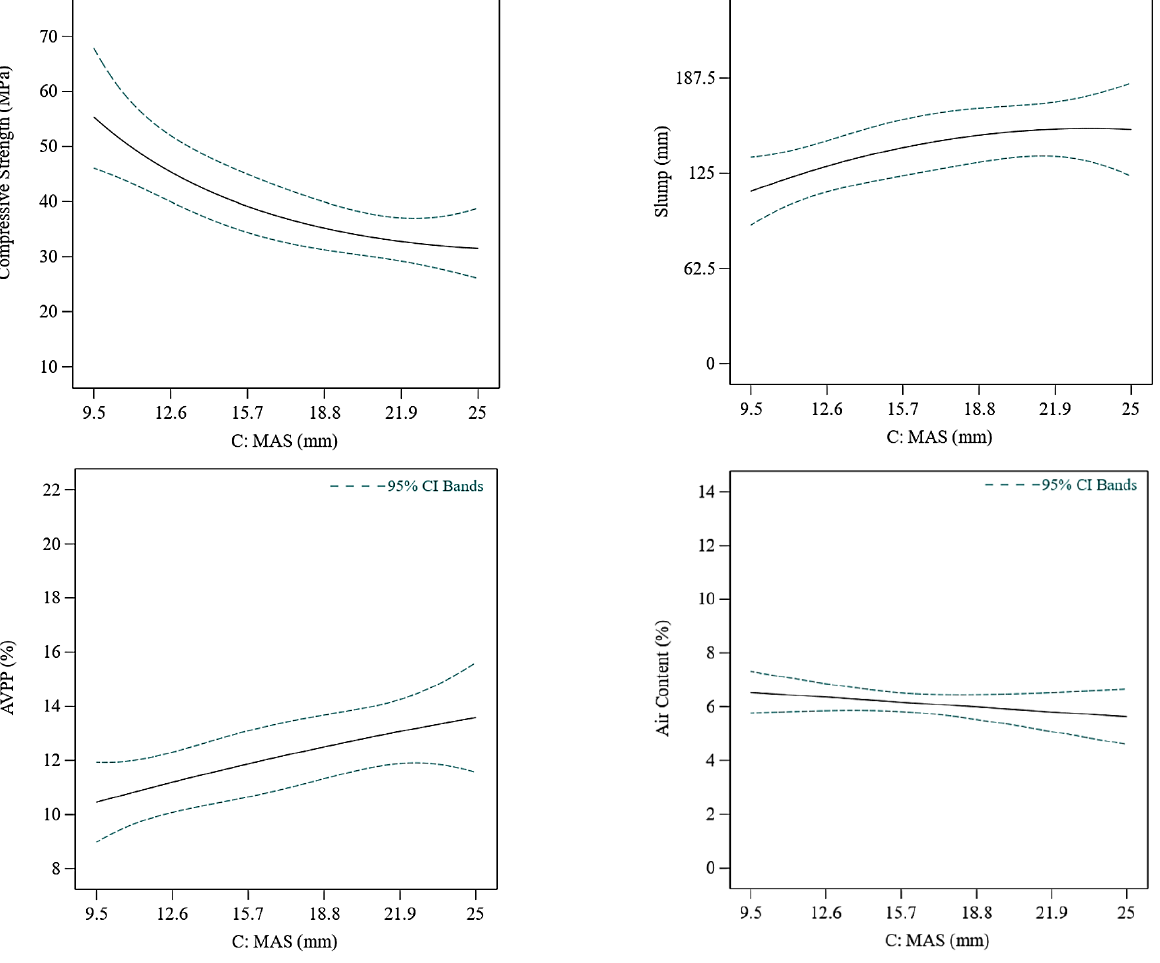
Figure 8. Effect of MAS on compressive strength, slump, AVPP, and air